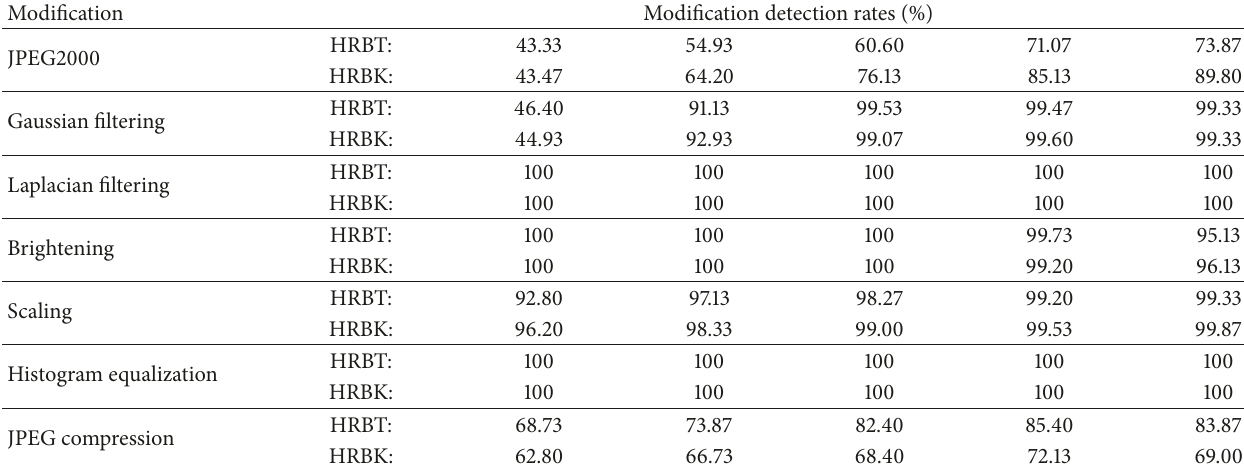
Table 3: Detection rates (%) with HRBT and HRBK features for different modification parameterizations (MR image dataset). Modification